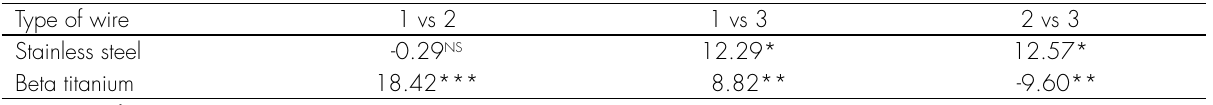
NS = not significant * = p <